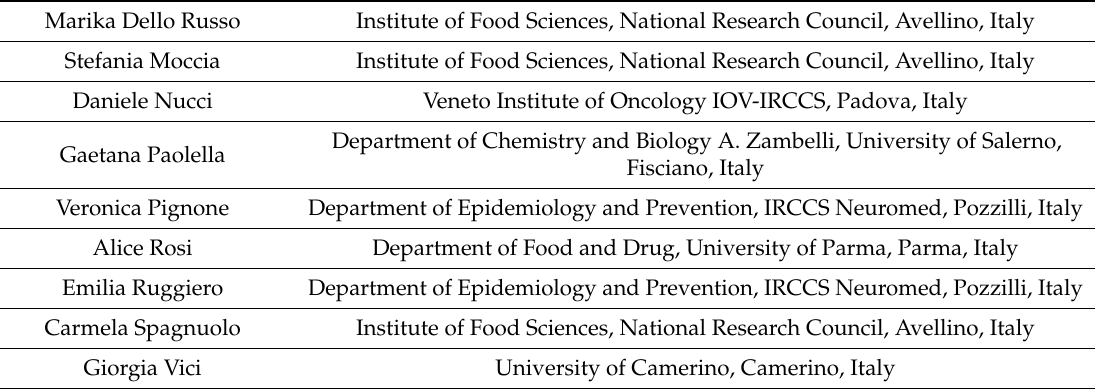
Table A1. SINU Young Working